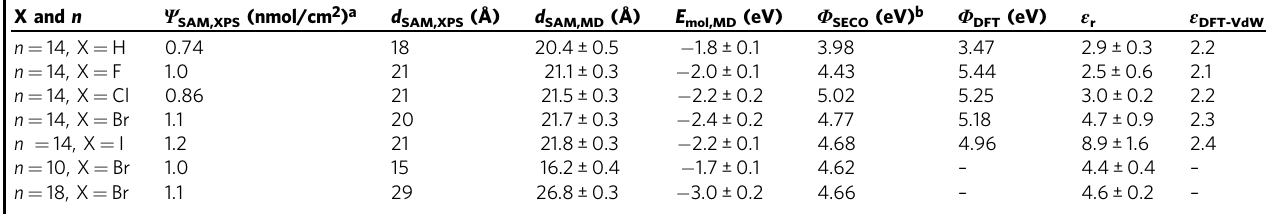
Table 1 Summary of properties of the Ag – S(CH 2 ) n X SAMs.